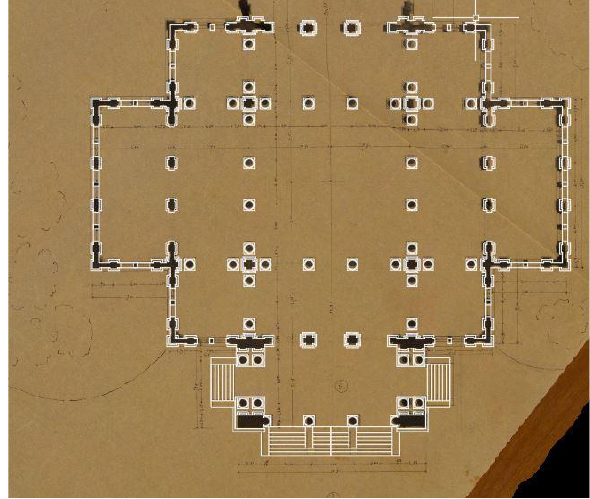
Figure 8. 2D redrawing on the digitized drawing of the plan of the City of Turin (Fondazione Marazza, Archivio Stefano Molli), in the upper right part the shift between the re-drawings on the basis of the quotation and the digital drawing is evident.